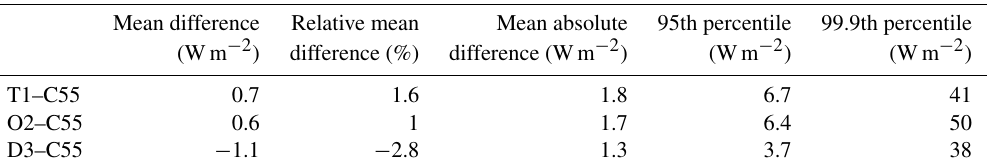
Table 2. Statistical characteristics of the difference in the latent heat flux calculated with and without explicitly accounting for sea waves: mean, relative mean (ratio of the mean difference to the mean value of the flux), mean absolute difference, 95th and 99.9th percentile, and the maximum difference for the Barents Sea Mean difference Relative mean Mean absolute 95th